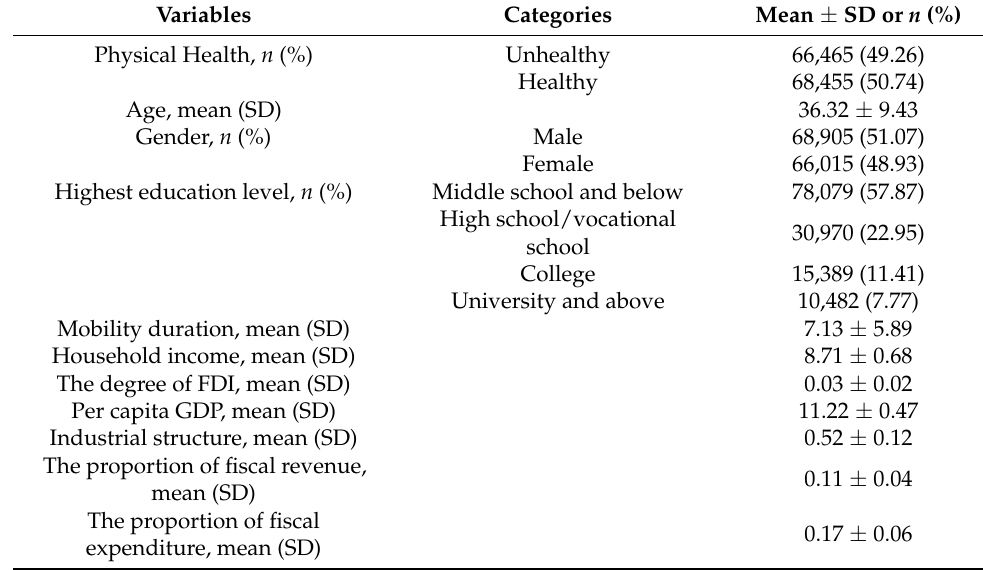
Table 1. Descriptive characteristics of participants ( n =